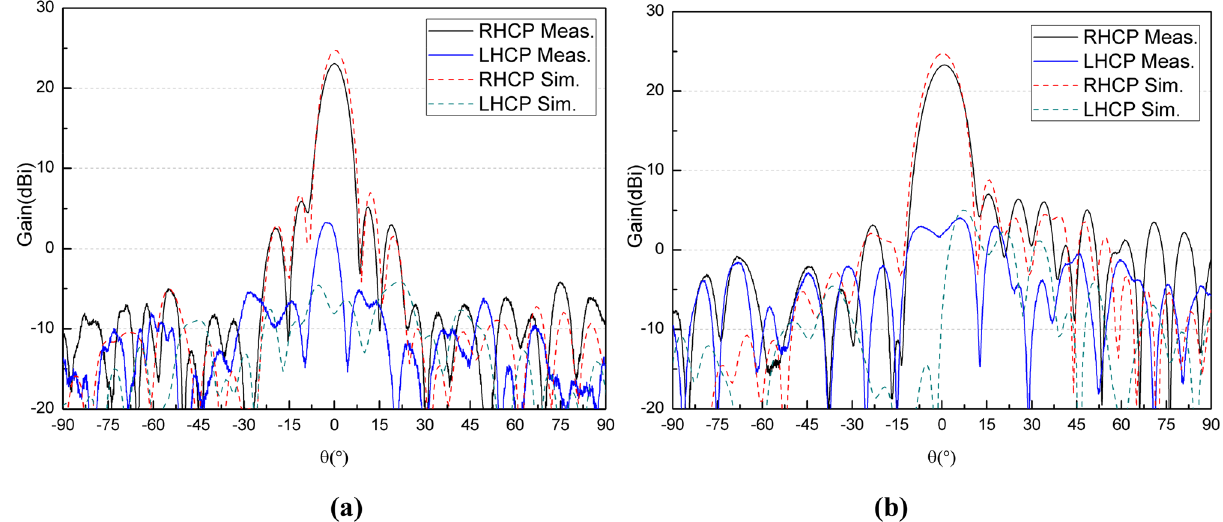
Figure 11. Comparison of measured and simulated gain radiation patterns (8.2 GHz): (a) the elevation and (b) the azimuth.